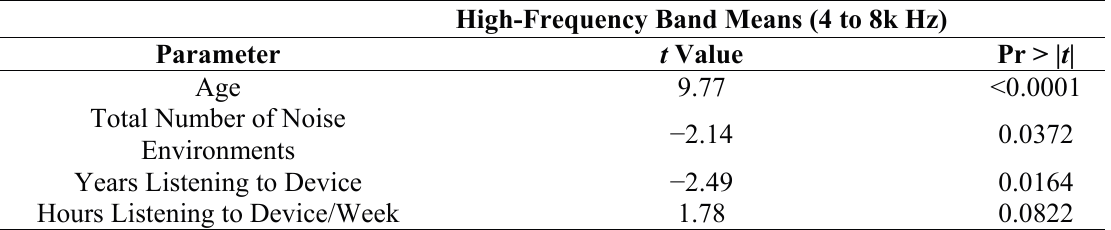
Table 4. Listening variables contributing to high-frequency band means for PLD